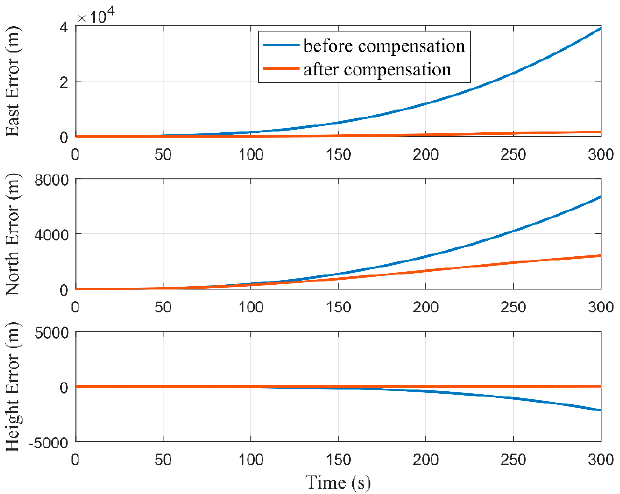
Figure 11. Positioning errors of pure navigation calculations before and after compensation of the MIMU biases.